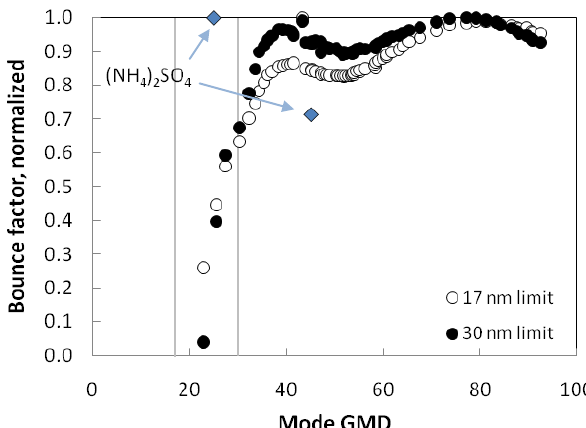
Fig. 1. Comparison of normalized bounce factors for measurements having 17nm (open circles) and 30nm (black dots) size limitations. In addition, reference measurements by ammonium sulphate parti- cles are shown (blue